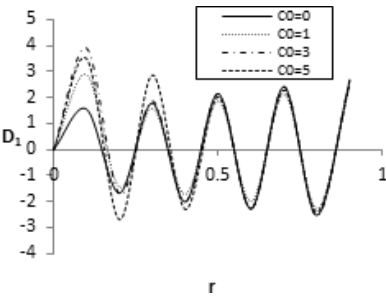
Figure 9: Distribution of electric displacement with the radius via RPL ℜ = 4